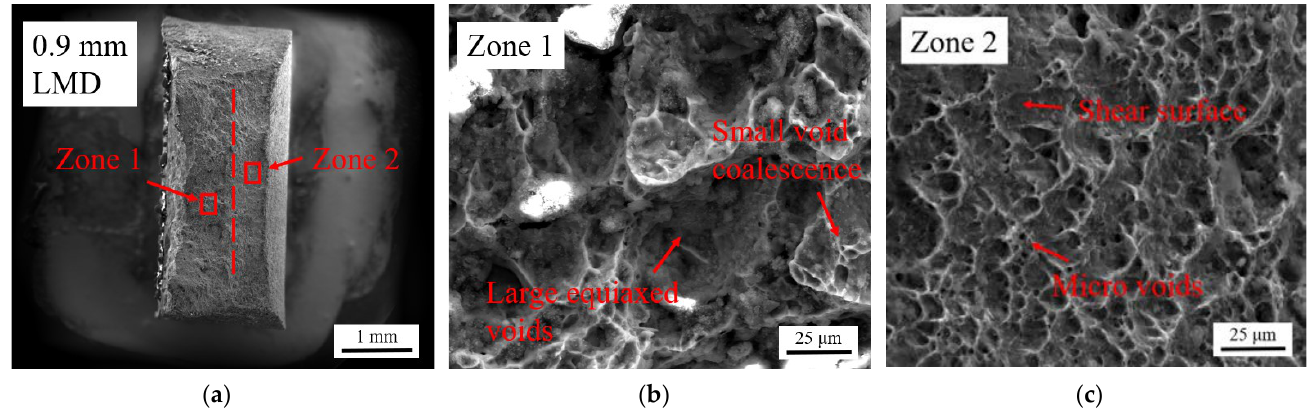
Figure 18. Fractography analysis of 0.9 mm LMD sample: ( a ) Differentiation between LMD added thickness (Zone 1) and non-transformed substrate (Zone 2); ( b ) High magnification of Zone 1; ( c ) High magnification of Zone 2.